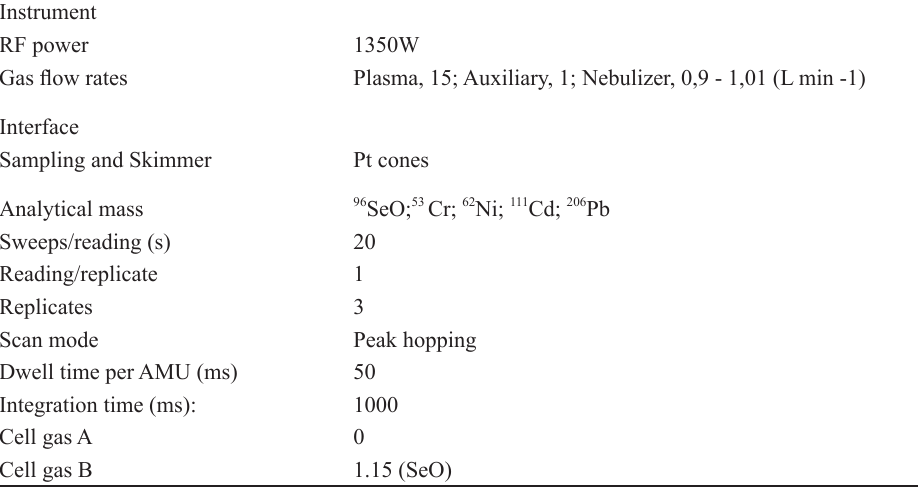
Instrument settings and data acquisition parameters for DRC